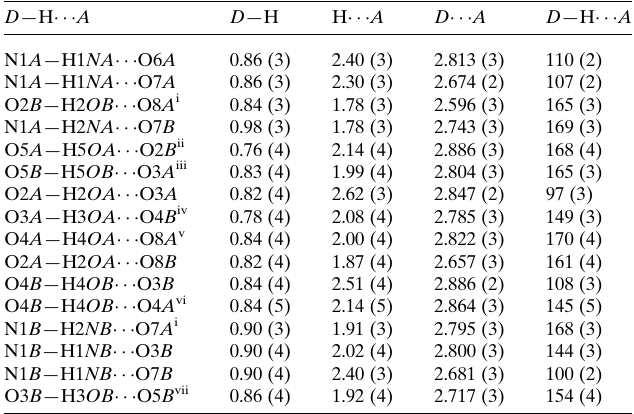
Table 1 Hydrogen-bond geometry (A˚ , (cid:3)